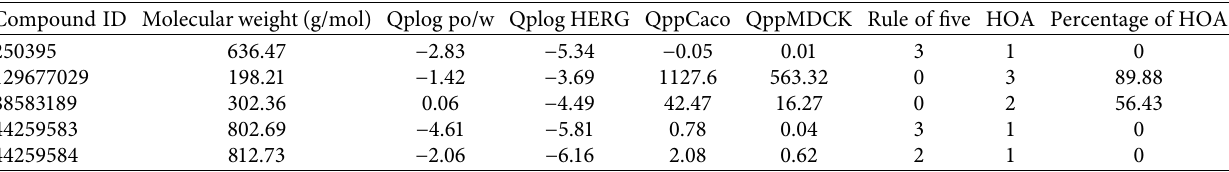
Table 6: ADME properties of the Kabasura Kudineer